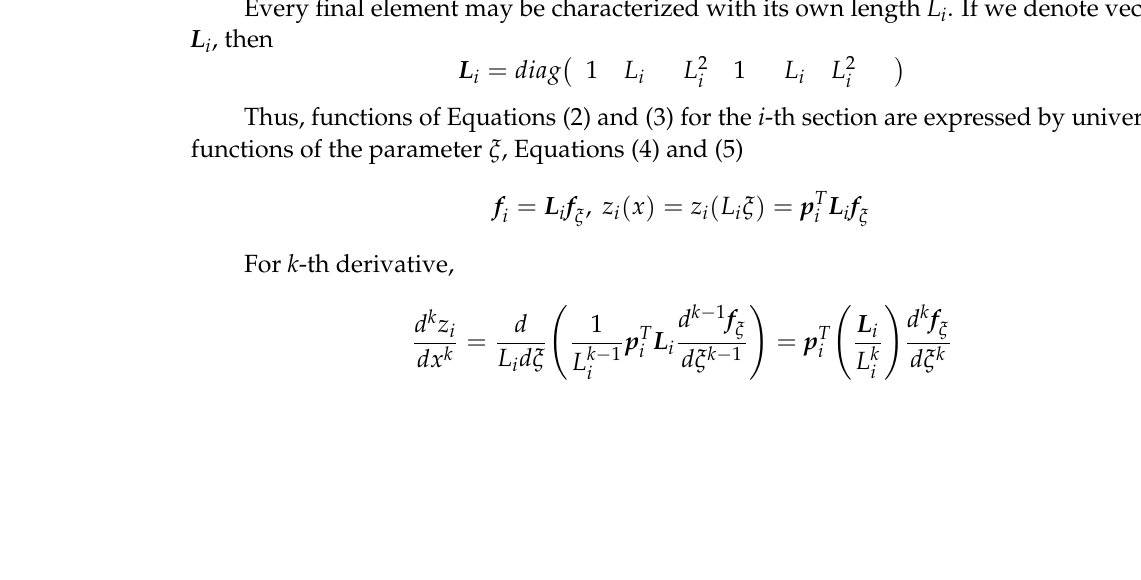
Figure 1. Basis functions of an FE with 3 DOF in a node: ( a ) offset, ( b ) rotation, and ( c ) rotation intensity.